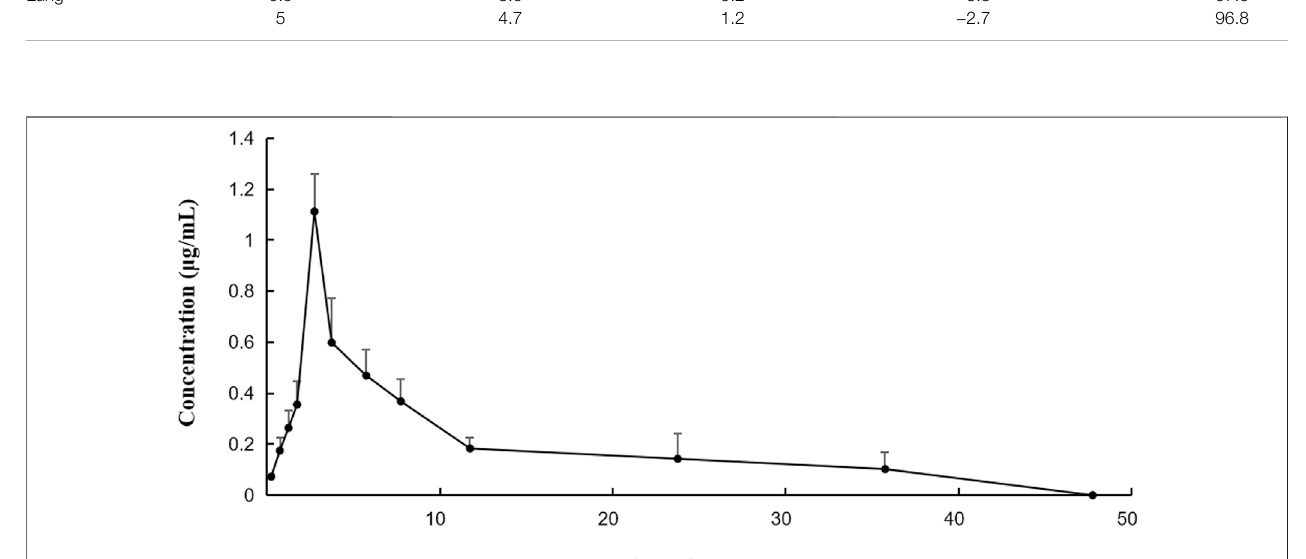
FIGURE 3 | Concentration – time curve of anwulignan in mice after the intragastric administration of anwulignan.